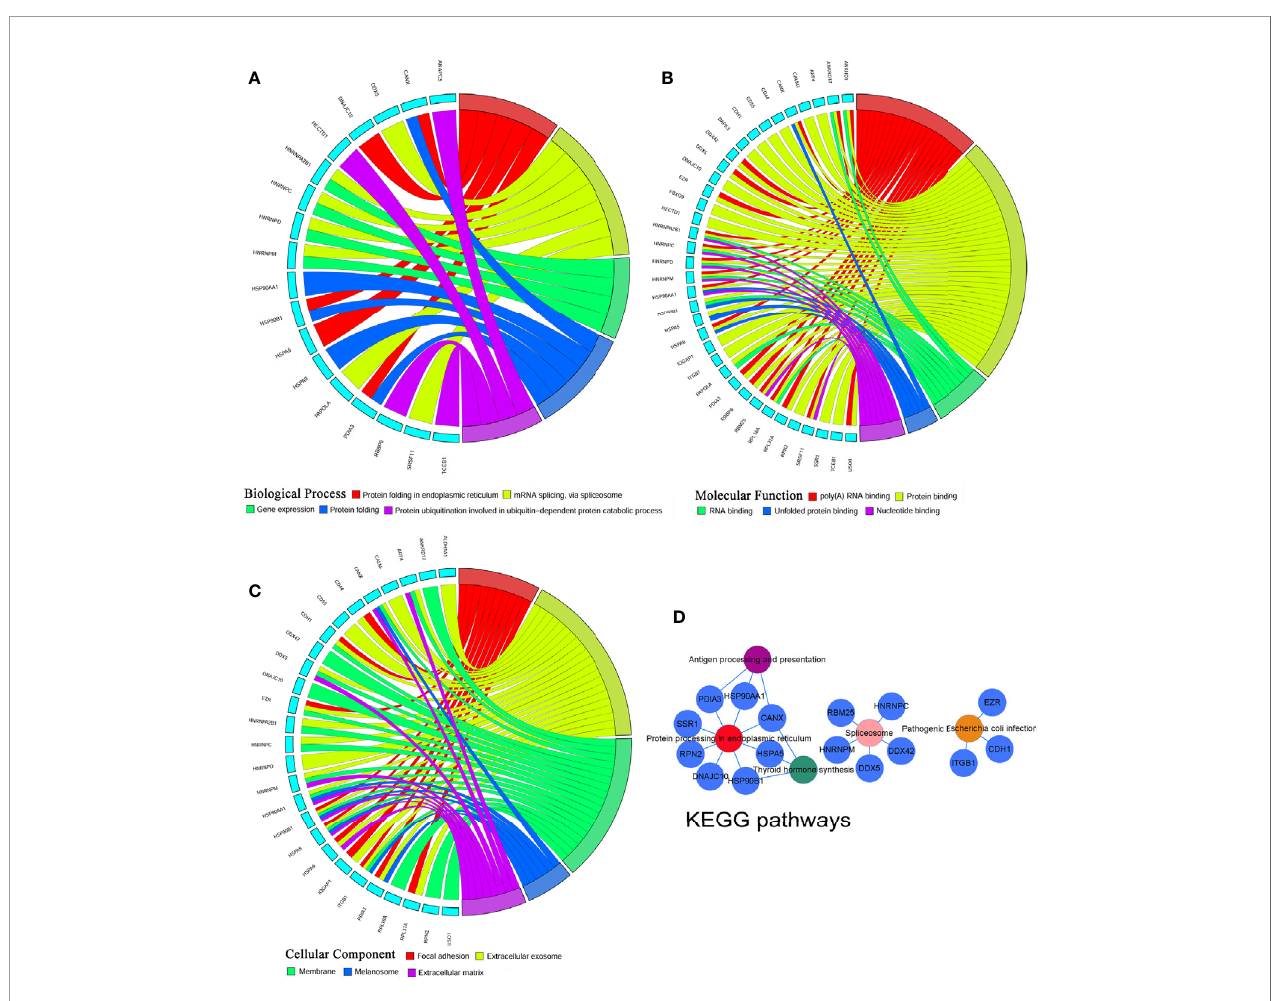
FIGURE 4 | Gene Ontology terms and Kyoto Encyclopedia of Genes and Genomes (KEGG) pathways of the module differentially expressed genes (DEGs) set. (A) Biological process, (B) Cellular component, (C) Molecular function, (D) KEGG pathways: Colors from red, pink, yellow, green to purple indicate that the P values are sorted from minimum to